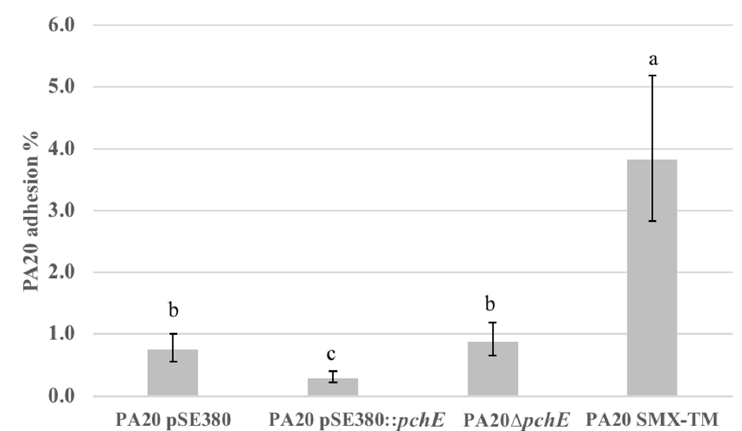
Figure 6. The effect of pchE and SMX-TM on strain PA20 adhesion to cultured HEp-2 cells. The calculated mean percentage values (and 95% confidence intervals) of two trials with three independent samples of each of adhered PA20 pSE380, PA20 pSE380:: pchE , PA20 ∆ pchE , and PA20 exposed to 540 / 208 µ g / L SMX-TM (PA20 SMX-TM) were determined following 3 h exposure to HEp-2 cells in EMEM at 37 ◦ C in 5% CO 2 . Any two treatment means with no letter in common are significantly different ( p < 0.05).